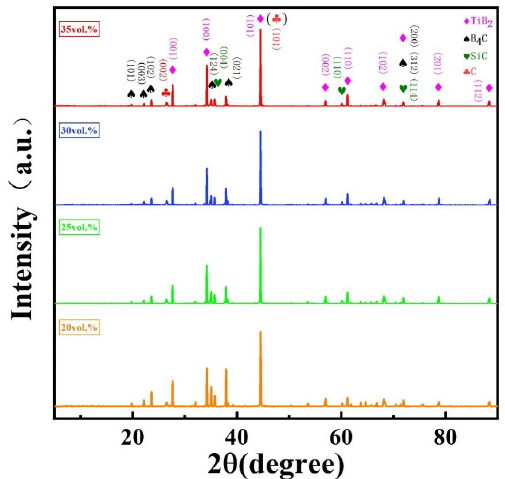
Figure 2. XRD patterns of B 4 C–TiB 2 ceramic composites sintered at 1900 °C with different contents of the additive Ti 3 SiC 2 .